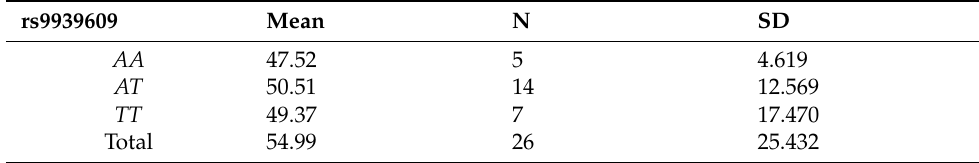
Table 6. Mean plasma nesfatin-1 levels (ng/mL) based on FTO